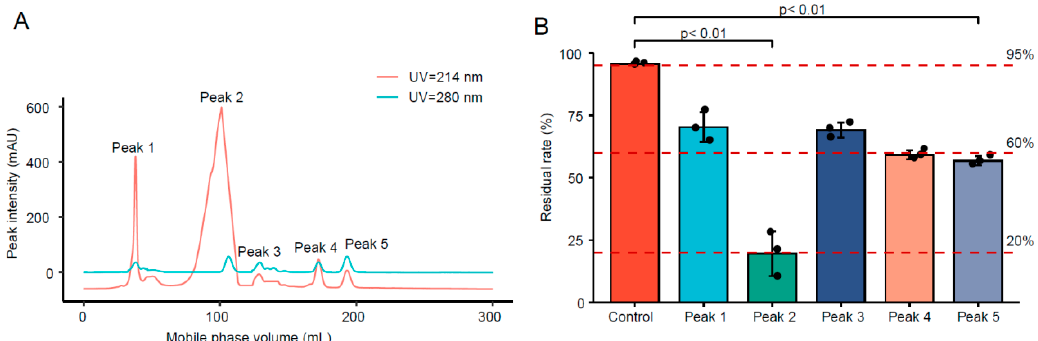
Figure 1. Protein separation, purification, and degradation activity of crude enzyme solution. ( A ) ÄKTA separation and purification results; ( B ) screening of protein degradation ability after purifi- cation.